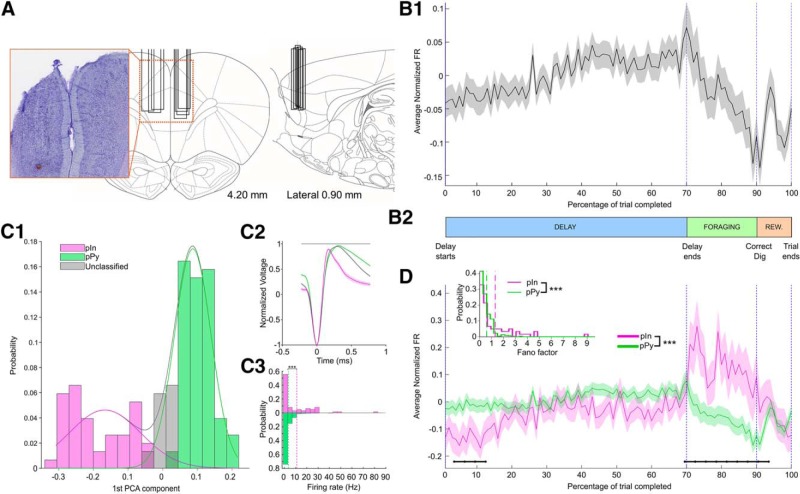
Task-normalized firing rates for pyramidal cells and interneurons. A, D, Coronal and sagittal rat brain sections depicting the location of the recording sites and photograph of a representative electrode placement. Probes were located in the prelimbic region of the mPFC. Box indicate the medial-lateral (left) and anterior–posterior (right) locations of the electrode arrays. B1, Grand-average (±SEM) of task-normalized firing rate for 382 neurons recorded across 77 recording sessions. Firing rates were z-scored before averaging across neurons. B2, Timeline of a single trial, where the three main epochs of the task (Delay, Foraging, and Reward) were identified through the four behavioral timestamps: Delay starts; Delay ends; Correct dig; and End of trial. Specific percentages of completion were assigned to each task epoch to calculate the task-normalized firing rates (see Data analysis – Task normalized firing rates). C1, Distribution of first PCA components (integrating two waveform features) for pIn, pPy, and unclassified neurons. The Gaussian fits used for the classification are shown as continuous lines on top of the distribution. C2, Mean waveforms (±SEM) for the three classes of neurons detailed in C1. Unclassified neurons had a mean waveform closer to the pPy class and where subsequently labeled as pPys. C3, Distribution of mean firing rates for 61 pIns and 321 pPy. Firing rates were higher in the pIn population than in the pPy one (Kolmogorov–Smirnov test, D(321,61) = 0.30, p = 1.1 × 10−4). Vertical dotted lines mark the mean value of each distribution. D, Grand-average (±SEM) of task-normalized firing rate for pIns and pPys. The firing rates in the two classes were significantly different (two-way ANOVA, interaction cell class × time, F(99,38000) = 3.02, p = 8.4 × 10−22). Black horizontal lines mark groups of time bins with significant differences between pIns and pPy (FDR-corrected rank-sum, p < 0.05). Top Left, Distribution of Fano factors for pPys versus pIns (dotted lines mark mean values). Pins exhibit higher trial-to- trial variability (Kolmogorov–Smirnov test, D(321,61) = 0.30, p = 9.8 × 10−5). ***p < 0.001.